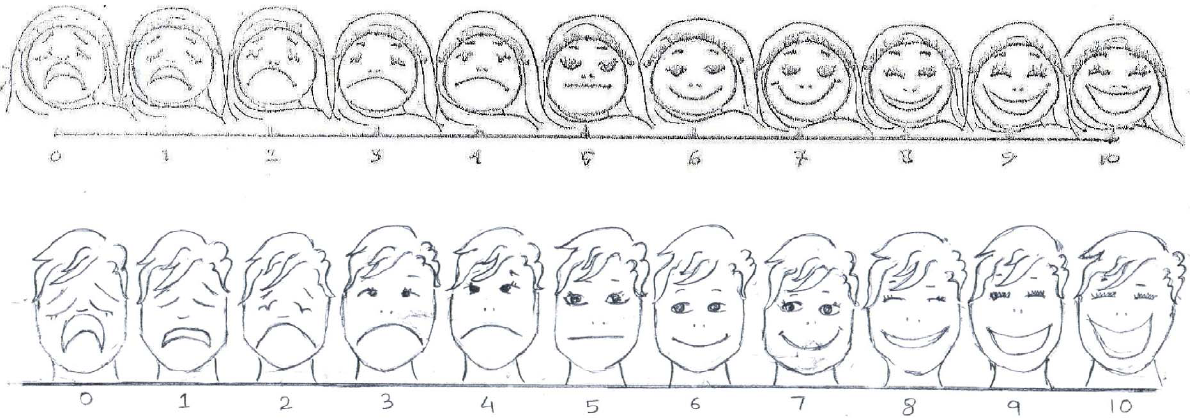
Figure 1. Scale of Severity . Separate pictorial scales, for both genders, used by the patient to score the magnitude of their mental health problem, assessed at their first mental health consultation, Timurgara district hospital, Pakistan (May - December